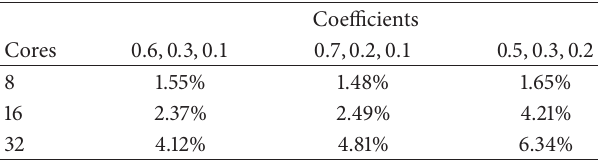
Table 4: Time difference for different coefficients and number of cores.